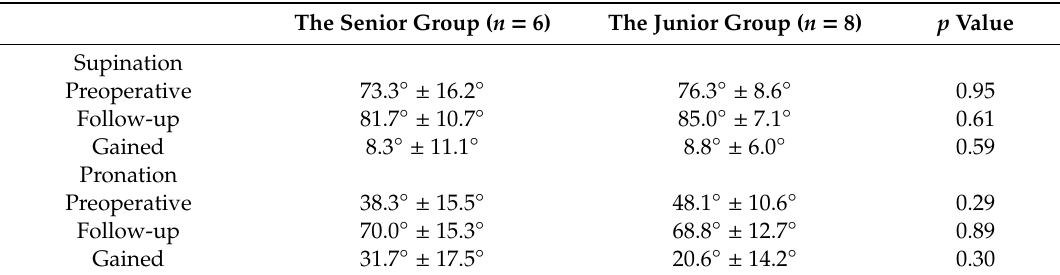
Table 2. Clinical